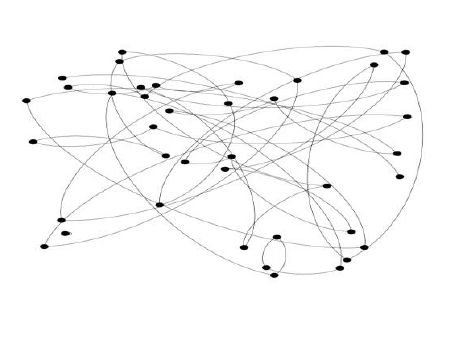
Figure 4. AIDS(HIV) network .